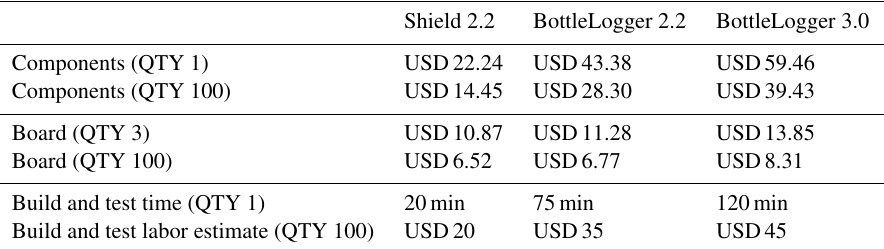
Table 2. ALog labor and pricing. All costs are given in US dollars. Component costs were found at Digi-Key (https://www.digikey.com/). Board prices were sourced from OSH Park (https://oshpark.com/). Build and testing times are based on our work with the data loggers, and the labor costs are estimated based on quotes from Caltronics Design & Assembly (https://caltronicsdesign.com/). All values are per board, and all prices were determined on 12 January